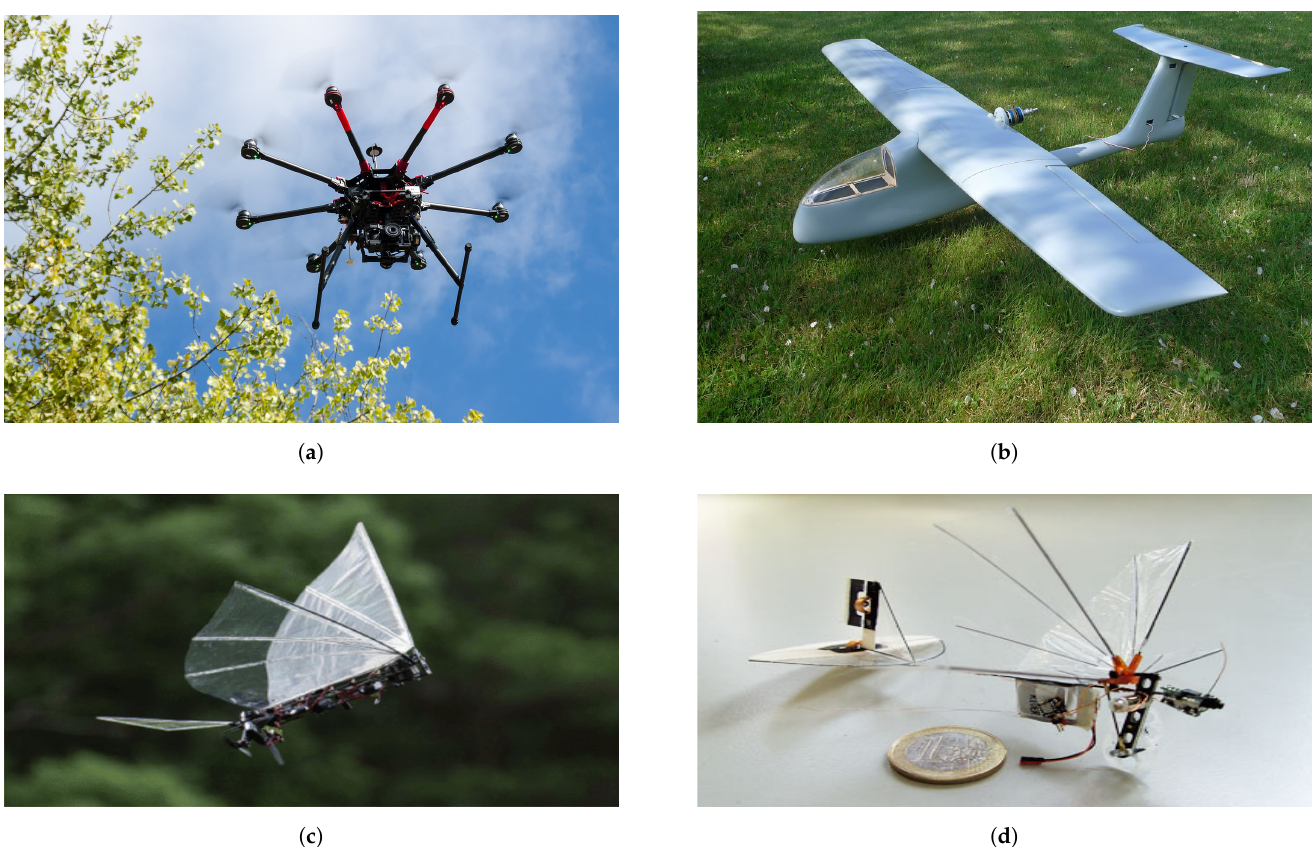
Figure 1. Different UAV types based on control configurations. ( a ) Multirotor (Hexacopter), ( b ) Fixed-Wing, ( c ) Ornithopter flapping-wing UAV (Robo Raven) [37], ( d ) Entomopter flapping-wing UAV (DelFly